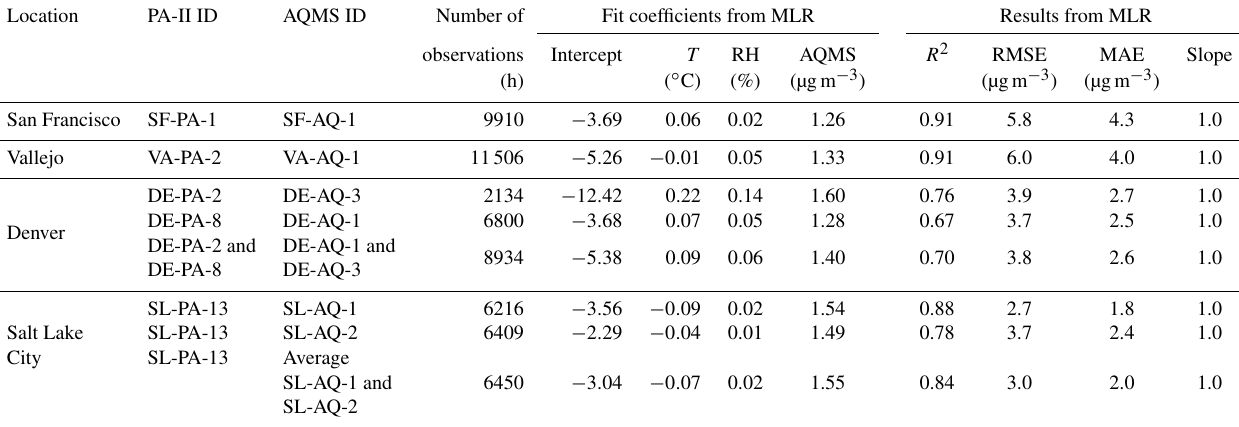
Table 1. Details of the coefficients received in each MLR and the linear regression output including R 2 , RMSE, MAE, and slope for each correction PA-II